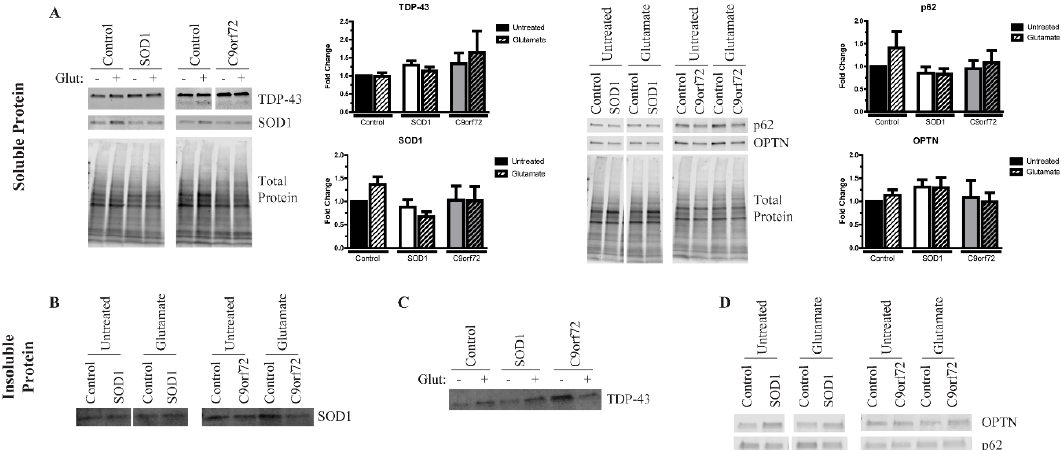
Figure 4. SOD1 and C9orf72 motor neurons have variable levels of insoluble protein. ( A ) SOD1 and C9orf72 MNs have similar levels of soluble SOD1, TDP-43, OPTN, and p62 compared to controls. n = 5–7. ( B ) Insoluble SOD1 is elevated primarily in SOD1 MNs, but not in C9orf72 MNs. These levels do not change after treatment with 100 µM glutamate. n = 5–7. ( C ) Western Blot of insoluble TDP-43 shows increased aggregation in SOD1 and C9orf72 MNs. SOD1 and control MNs tend to increase insoluble levels after glutamate stress, while the levels in C9orf72 MNs tend to decrease. n = 5–7. ( D ) SOD1 MNs tend to show higher levels of insoluble OPTN, whereas C9orf72 MNs show no apparent difference from controls. Insoluble p62 levels are unchanged in SOD1 and C9orf72 MNs compared to controls. n = 5–7.